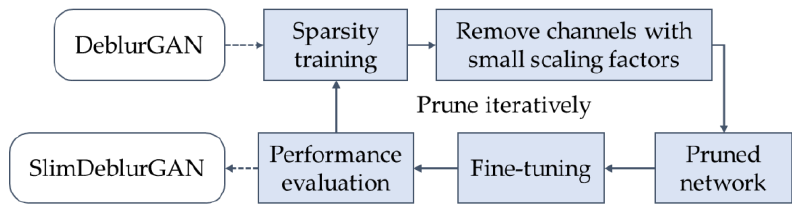
Figure 3. Iterative procedure of pruning of the DeblurGAN model through sparsity training and channel pruning for SlimDeblurGAN.